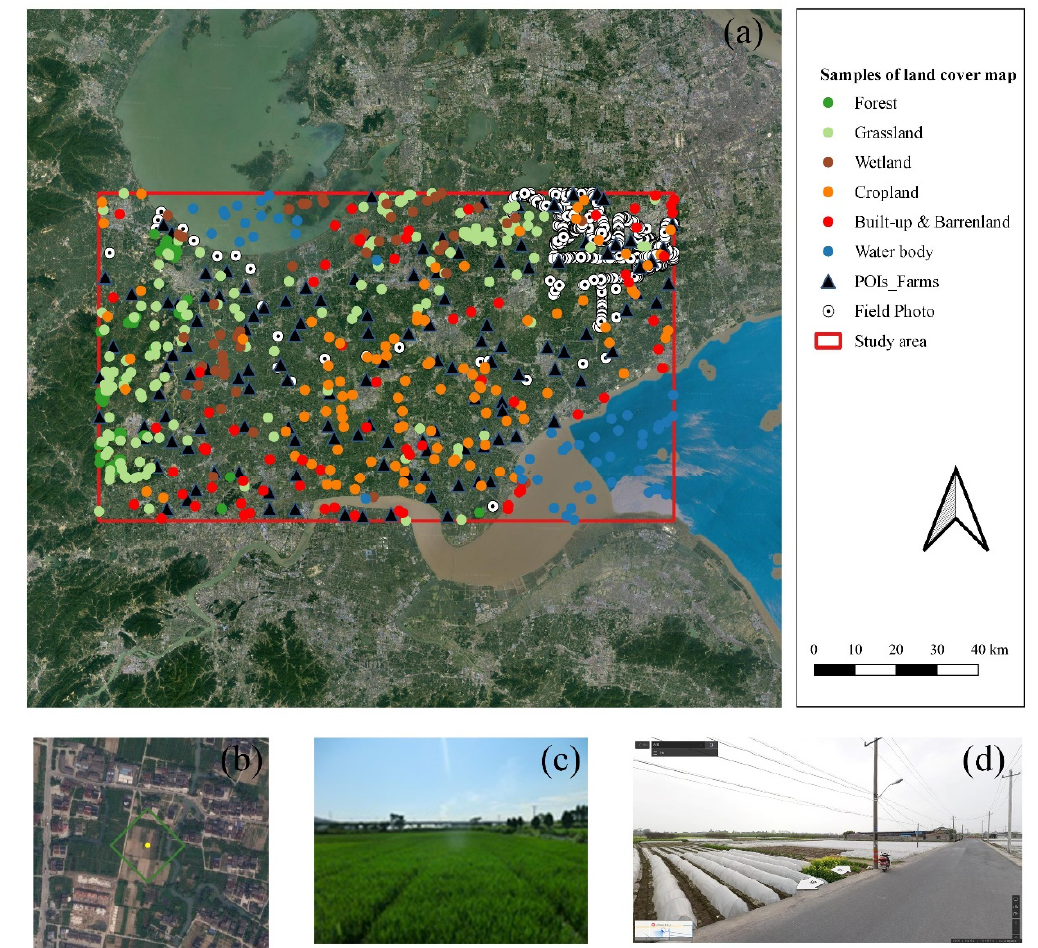
Figure 8. ( a ) is the distribution of stratified samples for points from the MCD12Q1 land cover map, farm POIs, and field photos; ( b ) is an example of a square AOI for one sample; ( c ) is an example of geo-referenced field photo acquired from ( d ) the site (http://www.eomf.ou.edu/photos/ (accessed on 1 March 2021)).